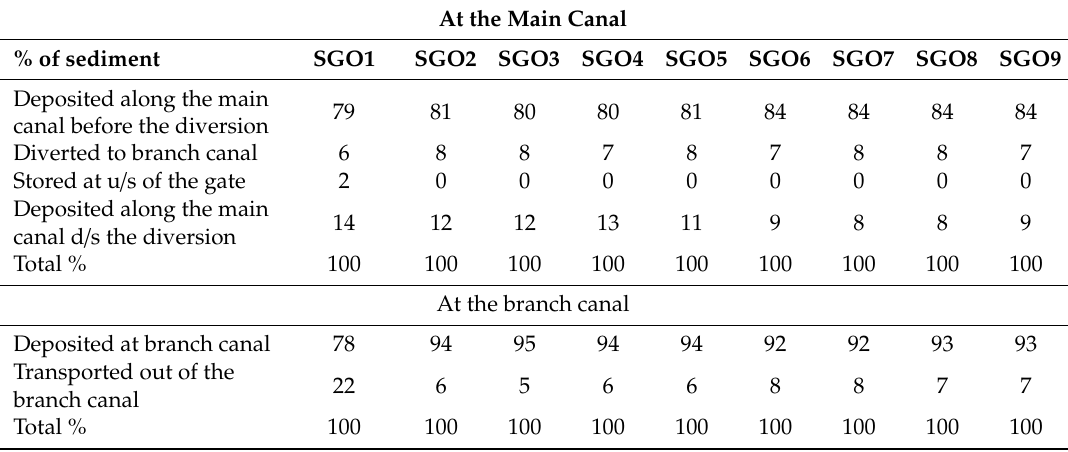
Table6. Percentageof sediment diverted and stored atthe main and branchcanals for di ff